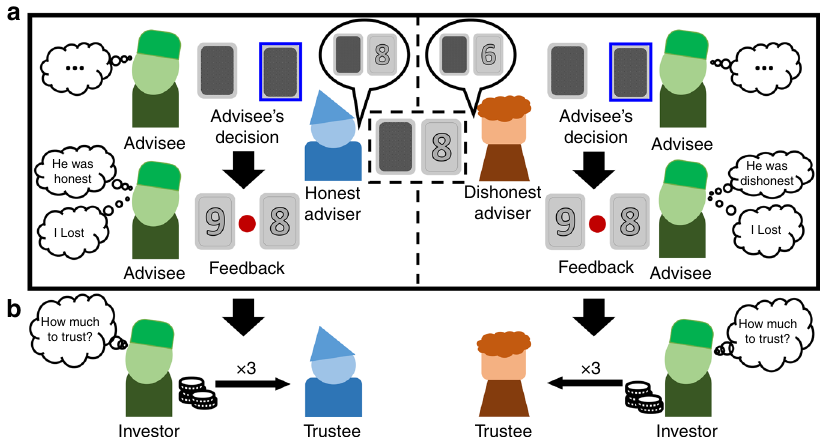
Fig. 1 Paradigms. a Schematic representation of the take advice game (TAG). Advisers were given information about one of the two cards and could communicate this information to the advisee. Participants, in the role of advisee, made a decision based on the information received (decision phase). In the feedback phase, advisees saw the actual numbers on the cards, which informed them about the adviser ’ s honest behavior (honest vs. dishonest), and a green or red circle, which informed them whether they won or lost, respectively. b After the TAG, participants in the role of investor played a one-shot trust game (TG) with the advisers now in the role of trustee. Investors received a monetary endowment and decided whether they wanted to entrust some of this amount with the trustees. Investors were told that the shared amount was tripled by the experimenter and passed on to the trustee, who could decide to share back any portion of the tripled amount. See also Supplementary Fig. 1